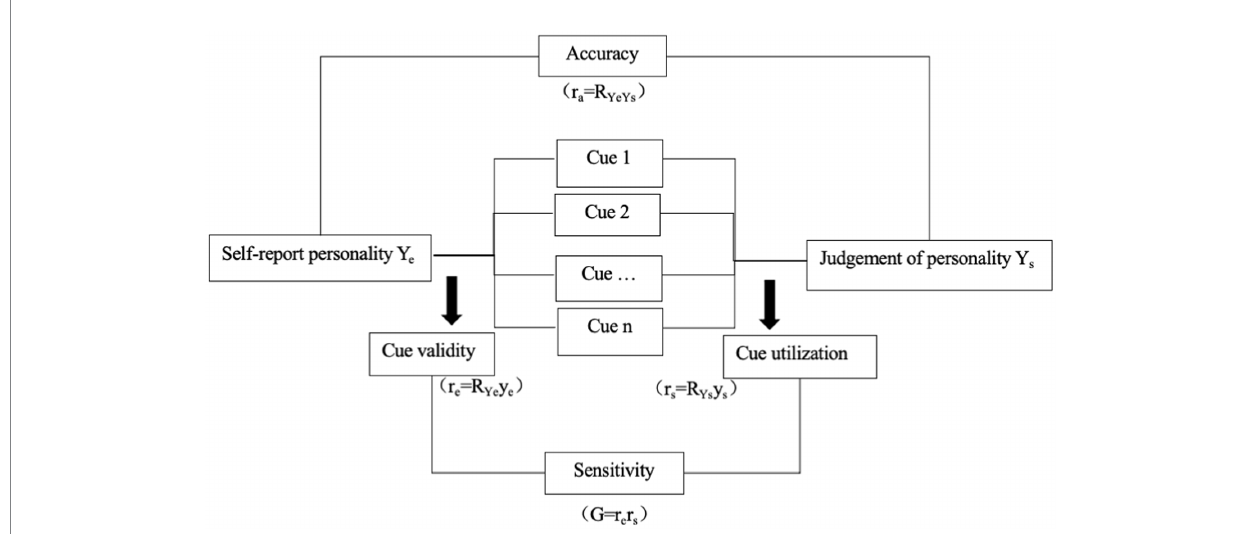
FIGURE 1 Diagram of the lens model. Adapted from “Determinants of Linear Judgment: A Meta-Analysis of Lens-Model Studies,” by Karelia and Hogarth (2008), and from “An Integrative Lens Model Approach to Bias and Accuracy in Human Inferences: Hindsight Effects and Knowledge Updating in Personality Judgments,” by Nestler et al. (2012), respectively, by the American Psychological